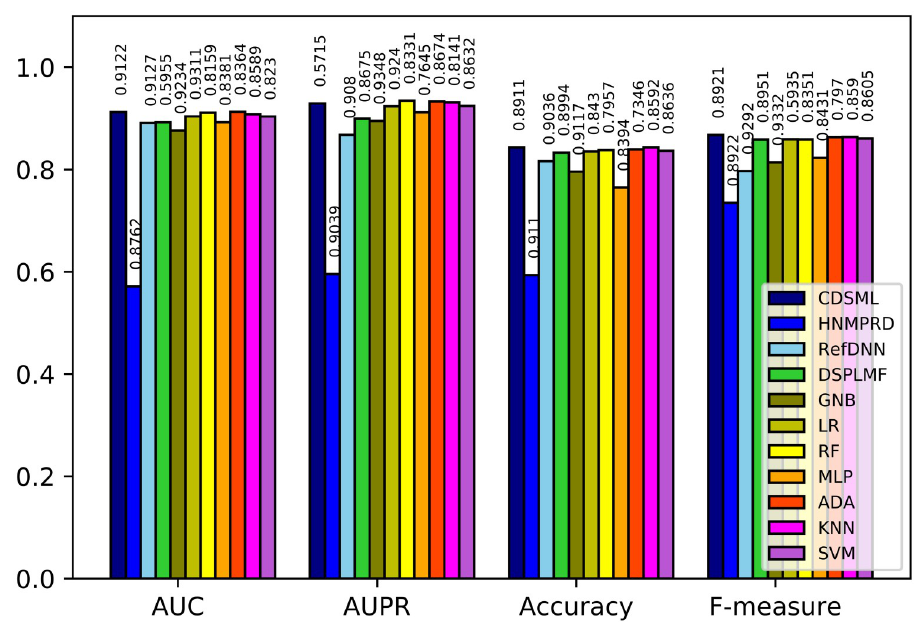
Fig 9. The performance of methods in on orogenital system